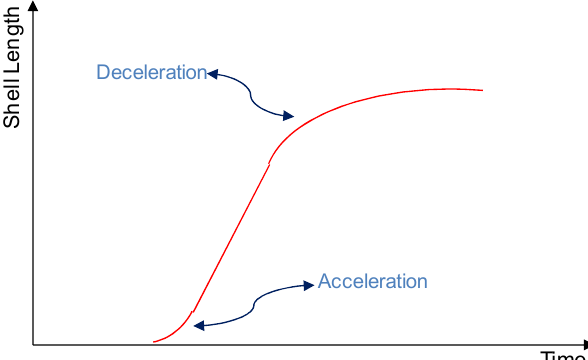
Figure A1. Schematic annual growth curve of individual blue mussels illustrating the acceleration and deceleration in the growth rate.